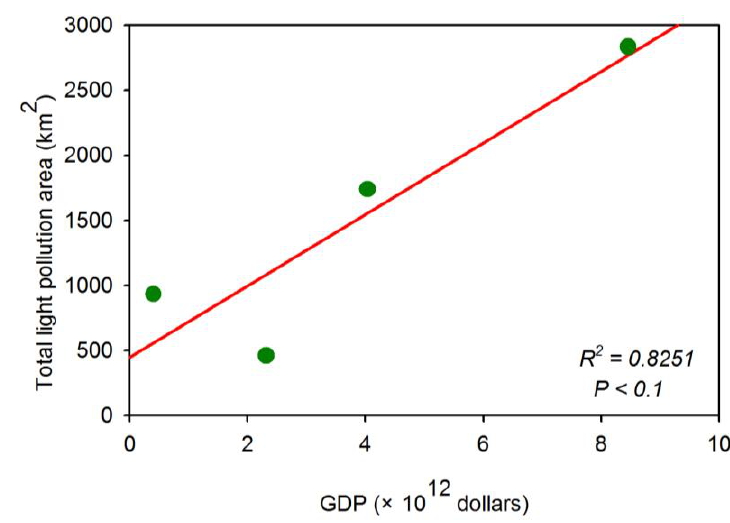
Figure 12. The correlation between the total light pollution area (refers to three light pollution level areas) and gross domestic product (GDP).